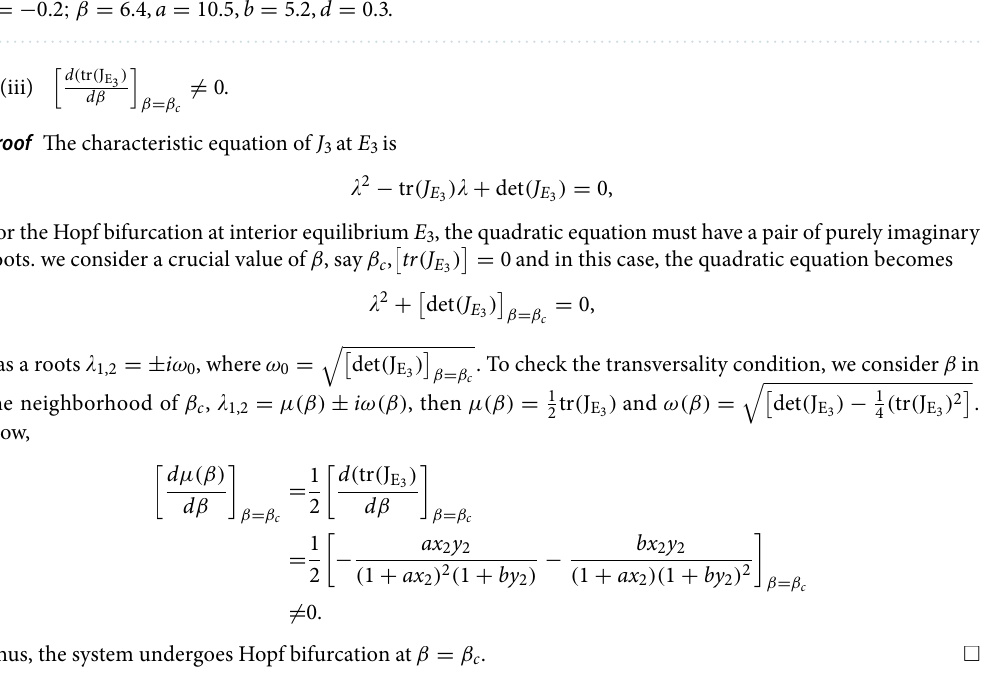
Figure 2. (Colour online) Weak Allee effect: prey-nullclines are identified by solid blue curves and, accordingly, predator-nullclines are recognized by solid red curves. ( a ) For l = − 0.2, β = 10.7, a = 10.9, b = 3.2, d = 0.3 , both the nullclines cross thrice, suggesting that there are three interior equilibrium points. ( b ) Three interior equilibrium points exist for l = − 0.2, β = 10.7, a = 10.9, b = 5.2, d = 0.3 . ( c ) For l = − 0.2, β = 11.494054912906, a = 10.9, b = 3.2, d = 0.3 , the two of the equilibria collide and consequently, there exist two interior equilibrium points. ( d ) One equilibrium exists for l = − 0.2, β = 1, a = 0.5, b = 0.9, d = 0.3 . ( e ) One equilibrium point exists for values l = − 0.2 ; β = 6.4, a = 10.5, b = 5.2, d = 0.3